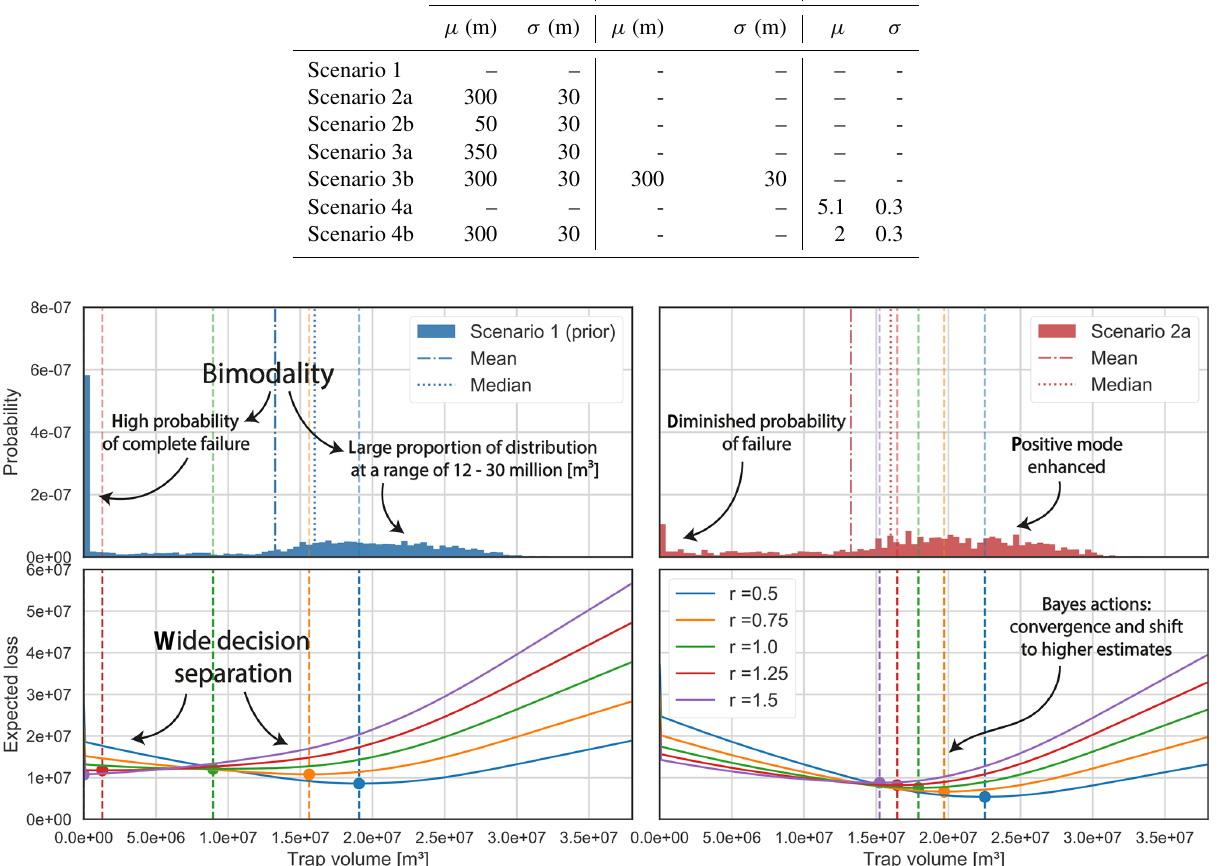
Figure 5. Trap volume distribution and resulting loss function realizations for Scenario 1 (prior) and Scenario 2a, in which we introduced the likelihood of a thick seal. Comparing both, we can observe how the additional information reduced the bimodality in the posterior distribution (2a), particularly by reducing the probability of complete failure and enhancing positive probabilities. Consequently, Bayes actions converged and expected losses were